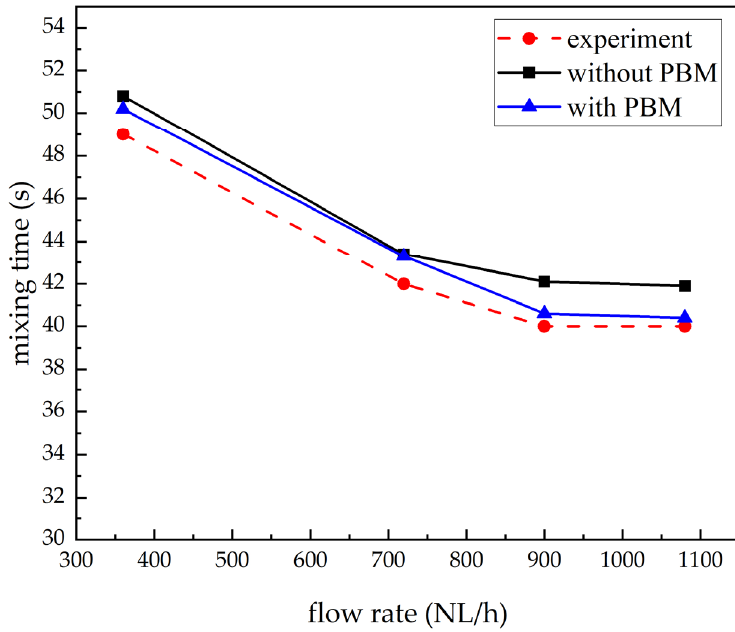
Figure 2. Mixing time comparison between calculated and experimental values at different flow rates.